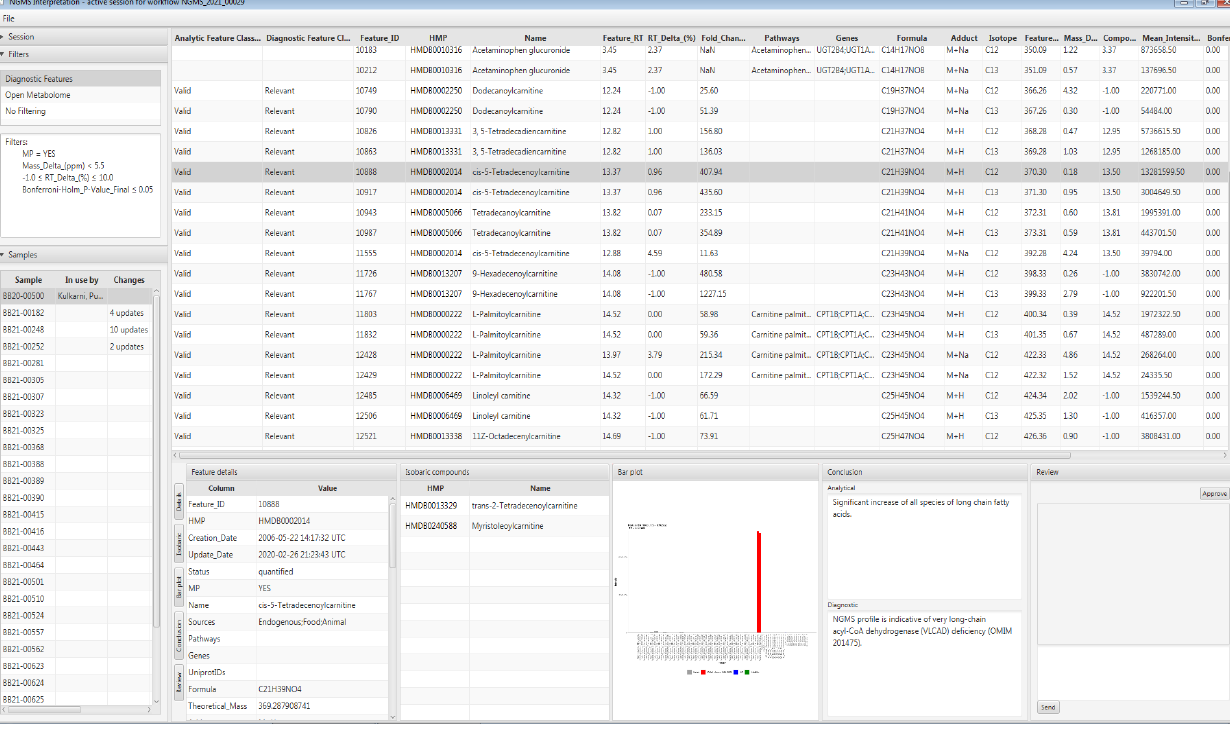
Figure 4. Screenshot of the interpretation tool with the selected patient sample and the diagnostically relevant mass features.